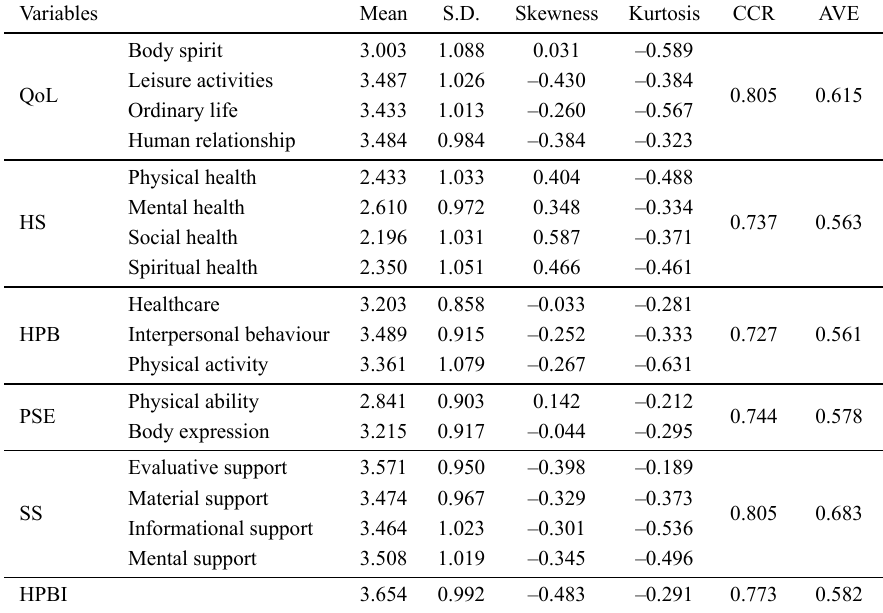
Table 2. Descriptive statistics and convergent validity of measured